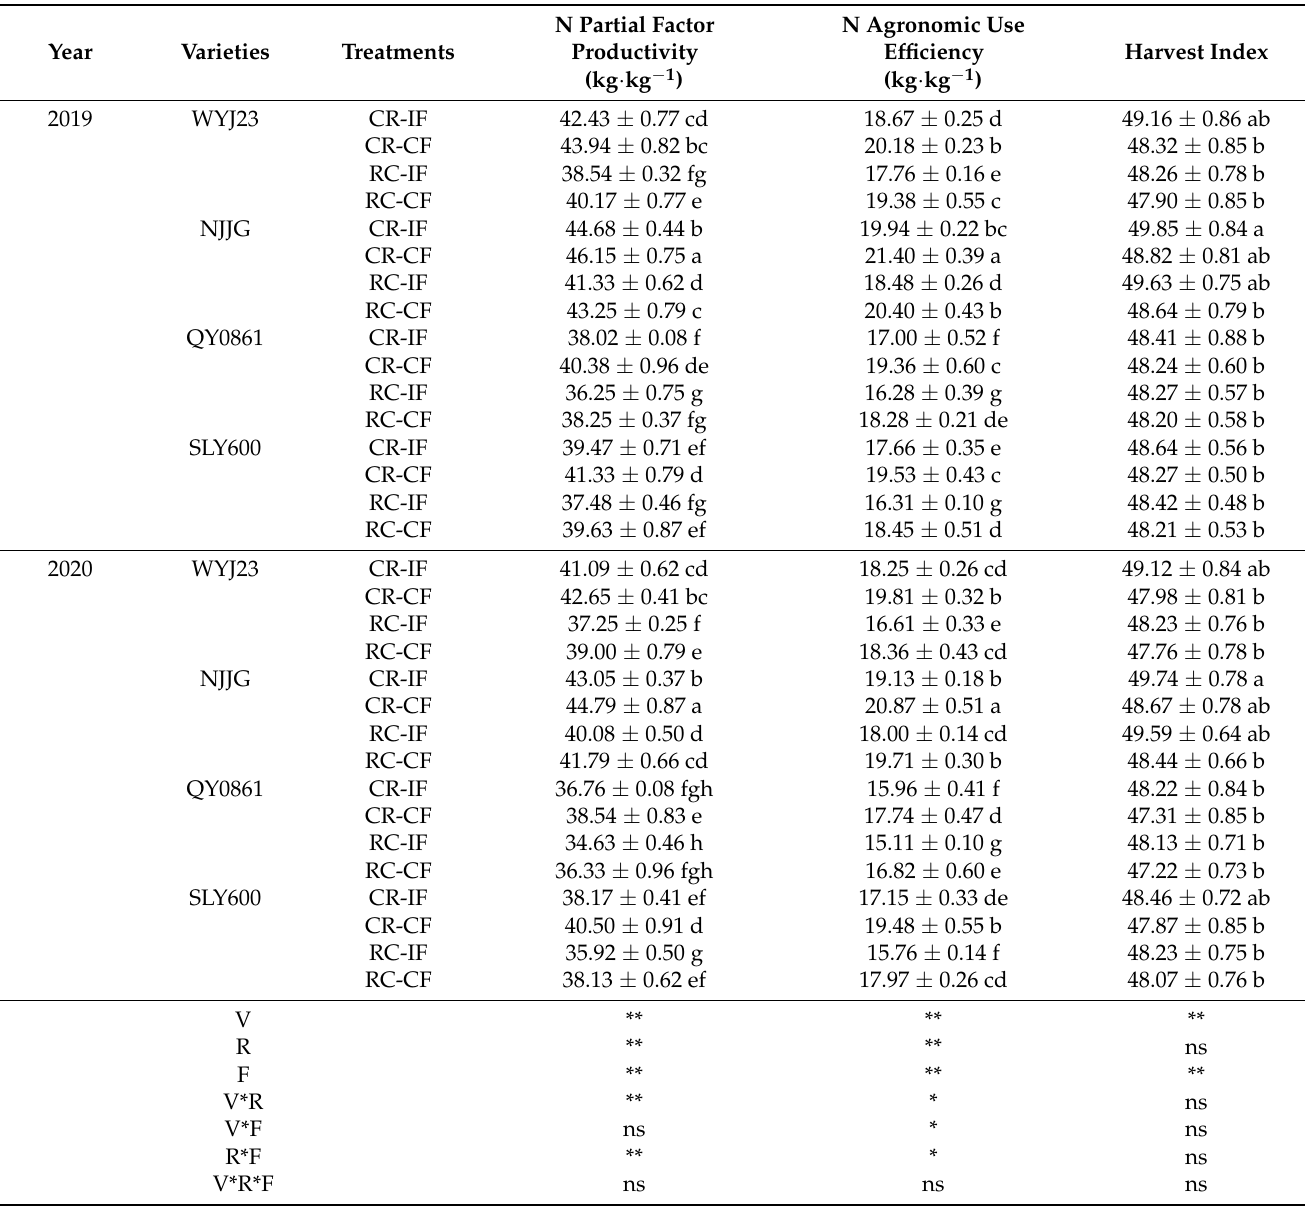
Table 5. Evaluation indexes of the dry matter utilization of different rice varieties under two types of fertilizer